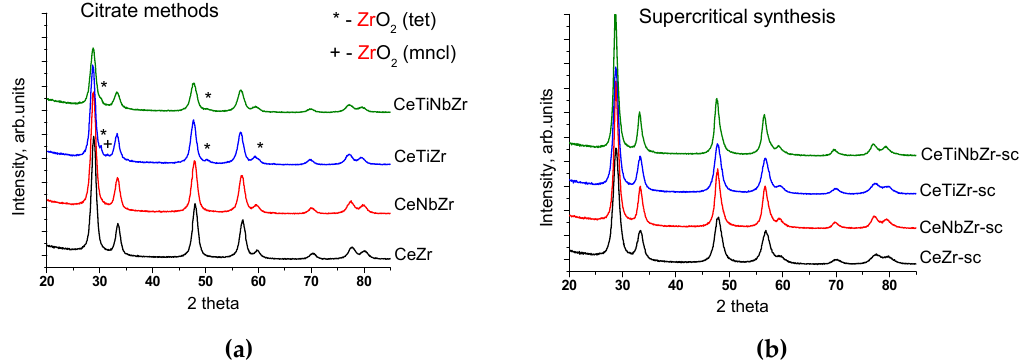
Figure 3. Di ff raction patterns of mixed oxides prepared by citrate methods ( a ) and by supercritical synthesis ( b ).